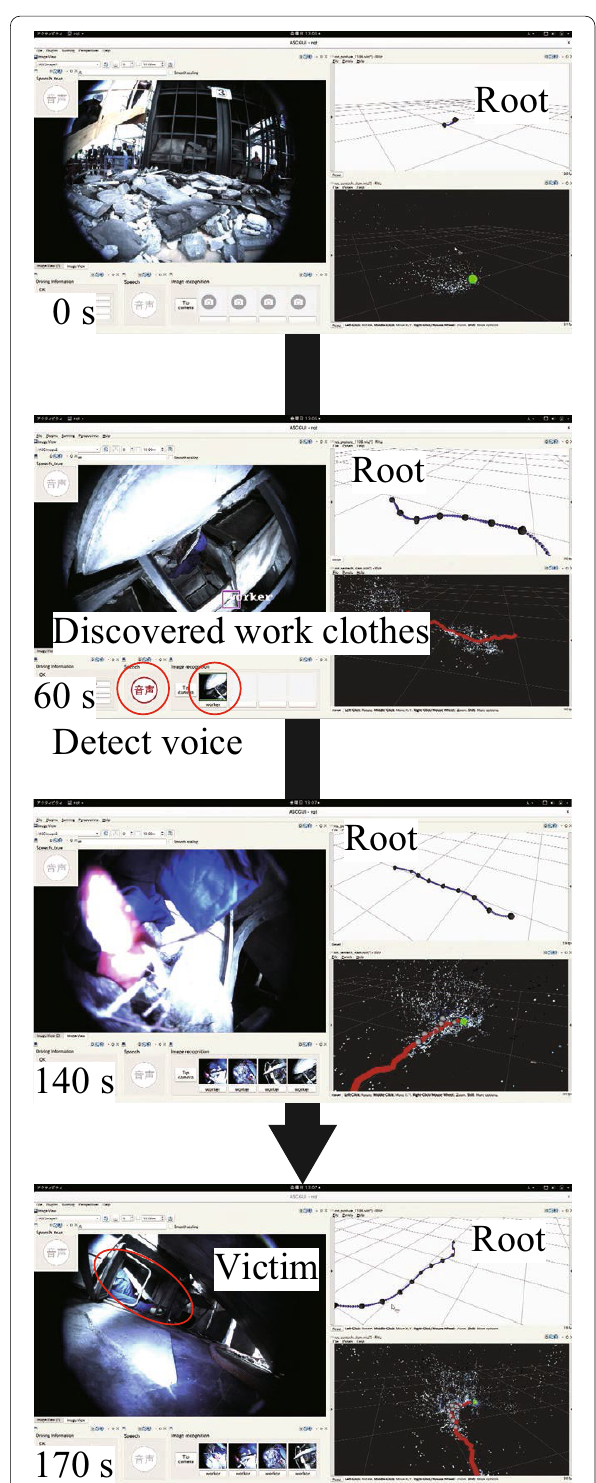
Fig. 15 Snapshot of the user interface. The robot was able to find the survivor by automatically recognizing the survivor’s characteristic work clothes and by estimating the robot’s shape and the movement trajectory of the tip